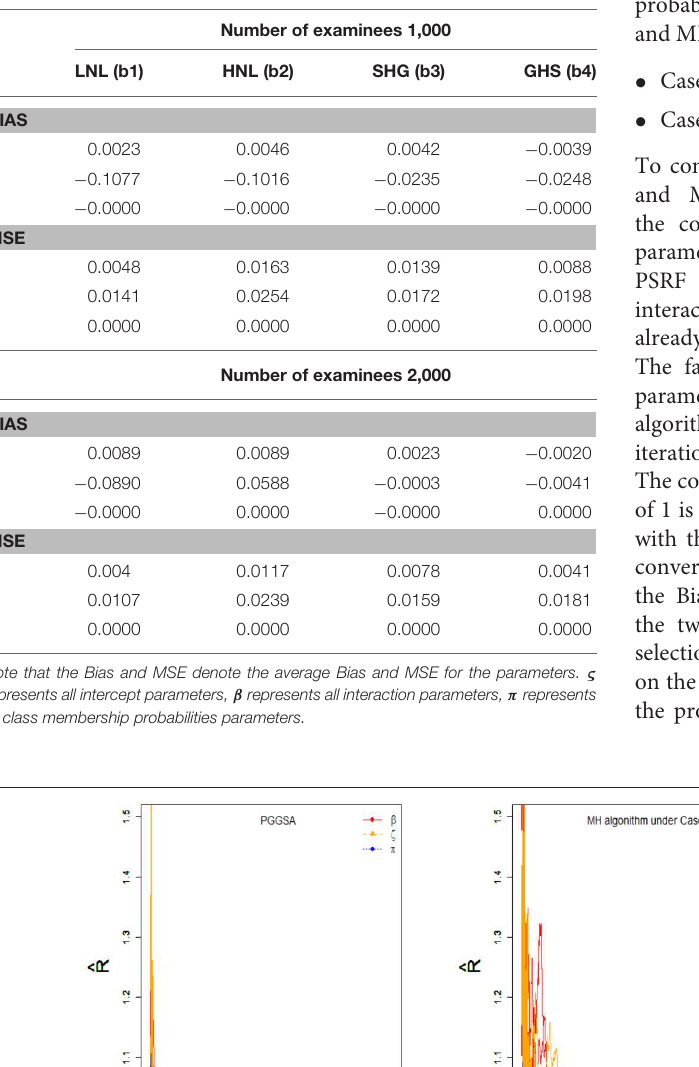
TABLE 2 | The average Bias and MSE for ς , β , and π .